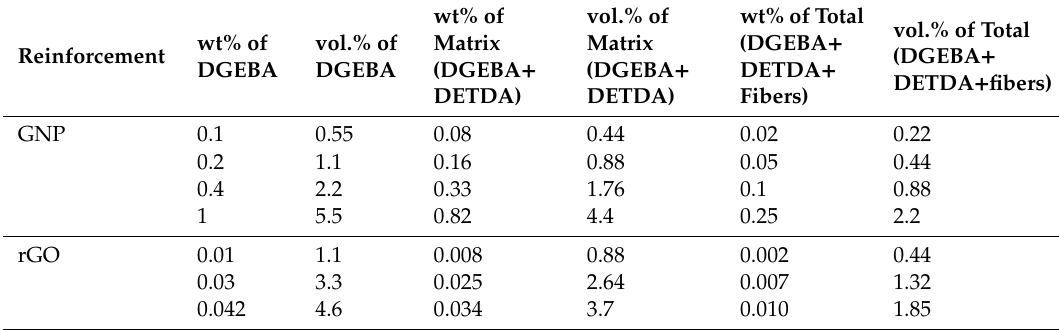
Table 1. Concentration of additives used for reinforcement of composites.